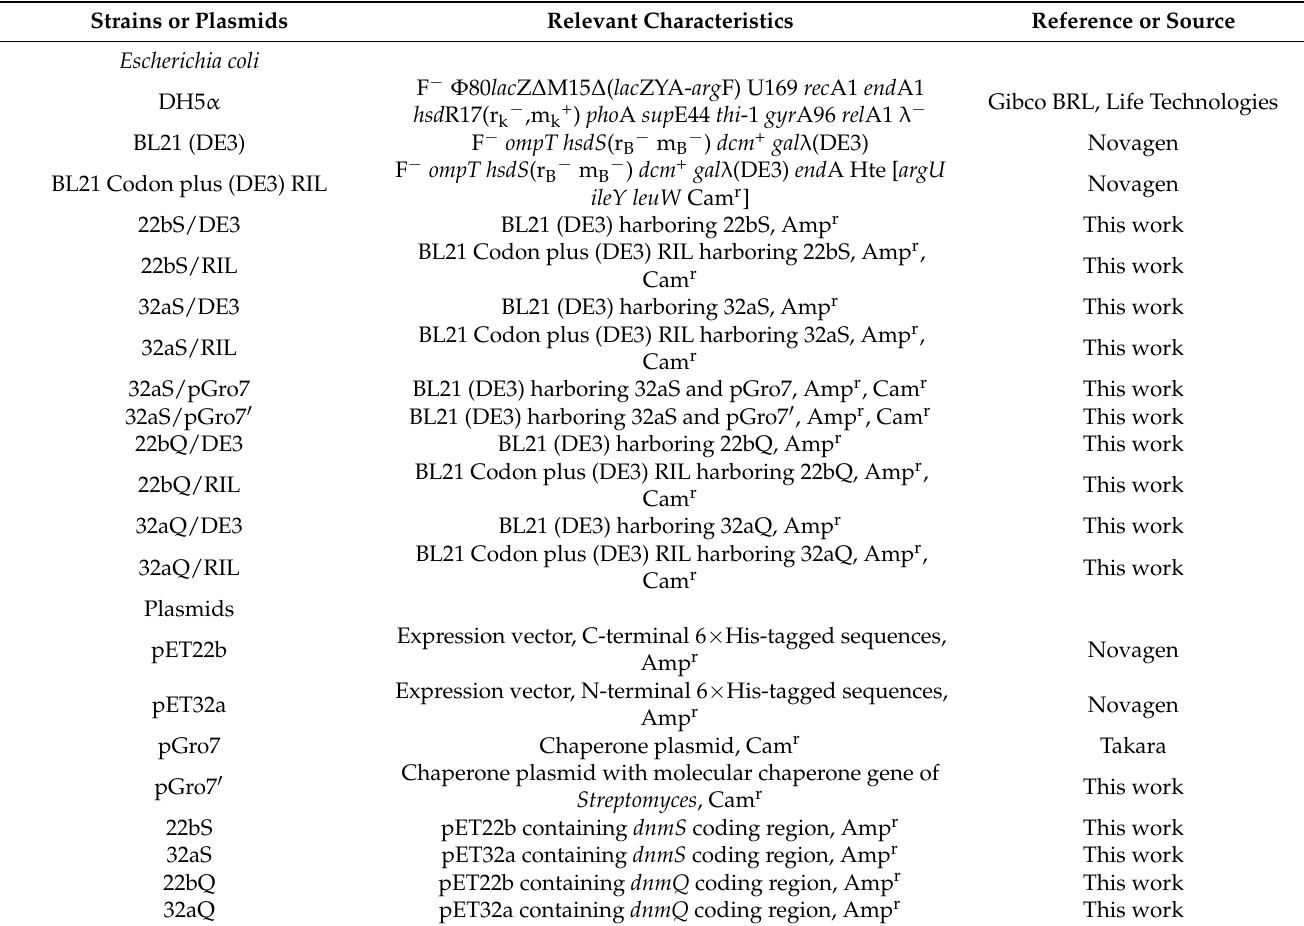
Table 1. The bacterial strains and plasmids used in this work.